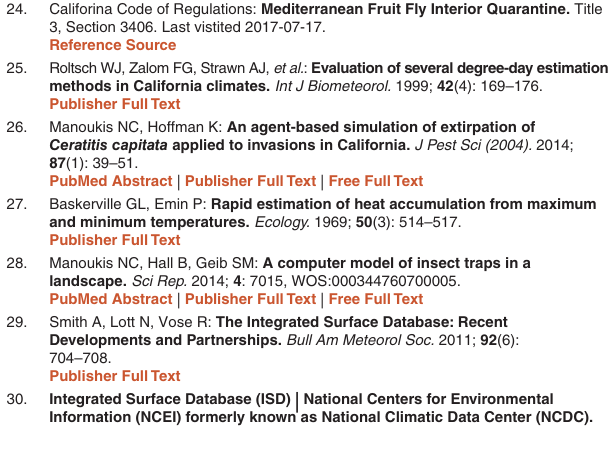
24. Califorina Code of Regulations: Mediterranean Fruit Fly Interior Quarantine. Title 3, Section 3406. Last vistited 2017-07-17. Reference Source 25. Roltsch WJ, Zalom FG, Strawn AJ, et al. : Evaluation of several degree-day estimation methods in California climates. Int J Biometeorol. 1999; 42 (4):